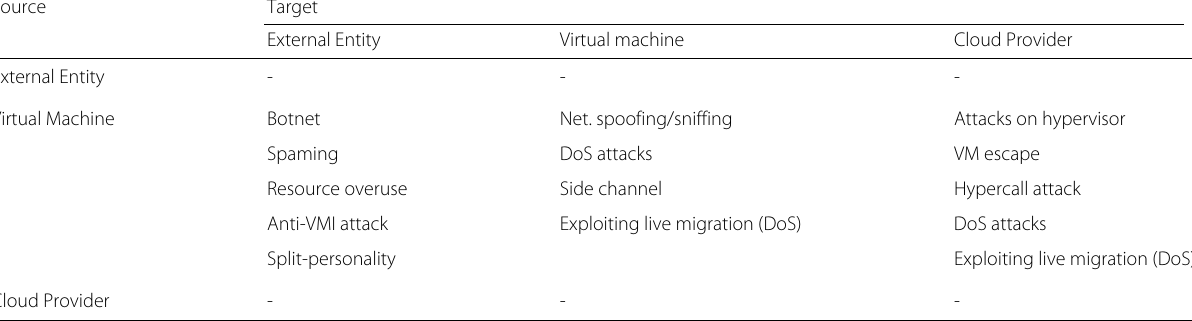
Table 3 Class 3: Attacks originating from